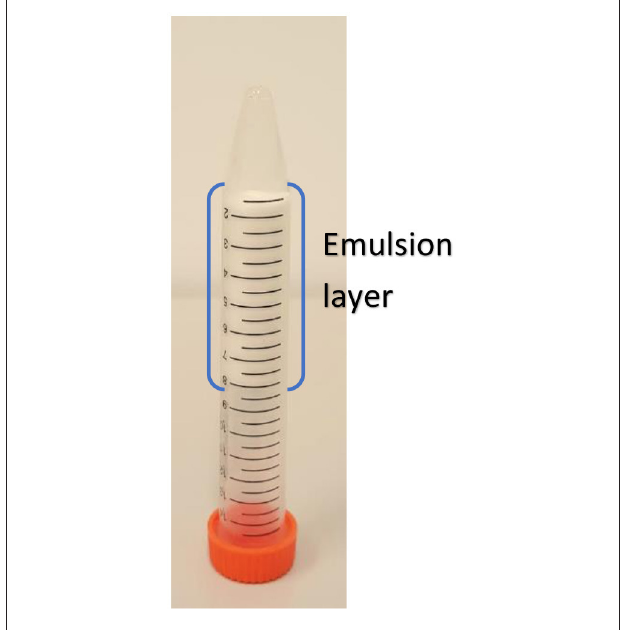
FIGURE 9 | Photograph of C. Oil/water emulsion with 3 wt% CNC and 100mM NaCl after centrifugation.